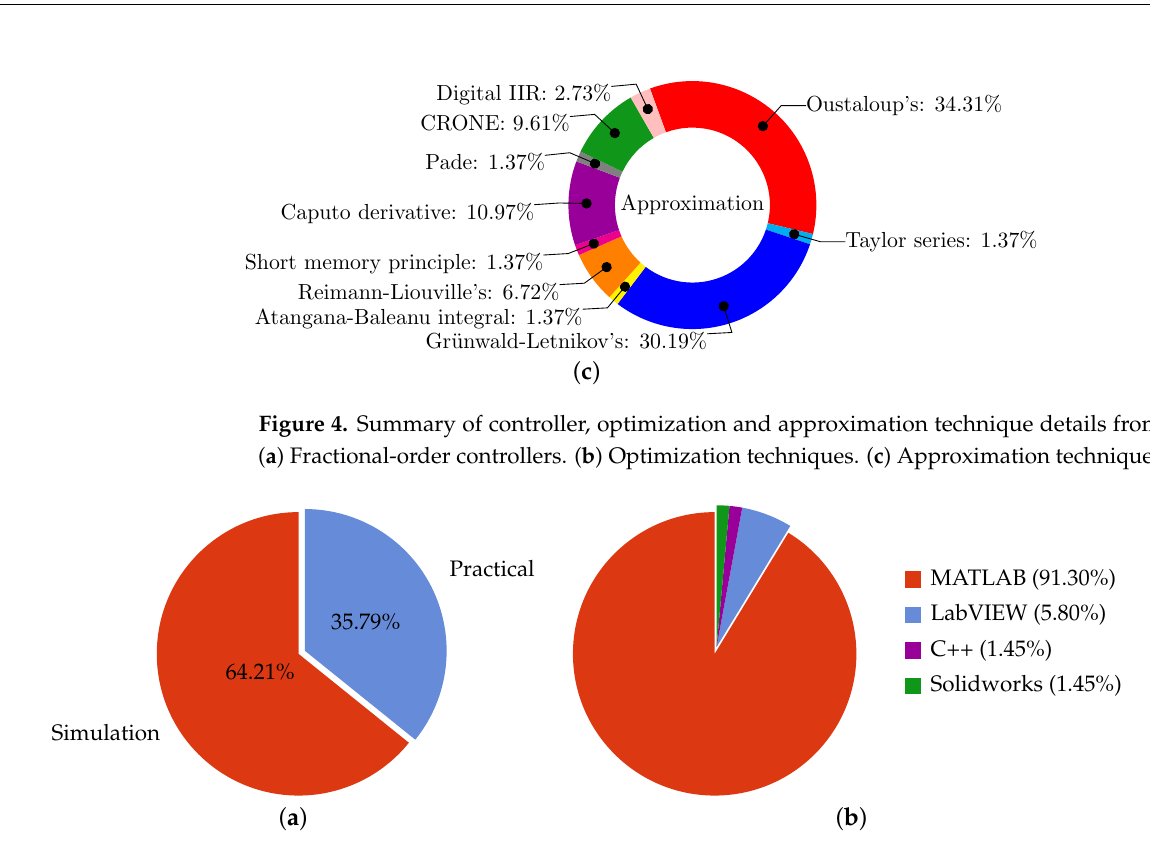
Figure 5. Summary of implementation type from Table 1. ( a ) Validation type. ( b ) Software